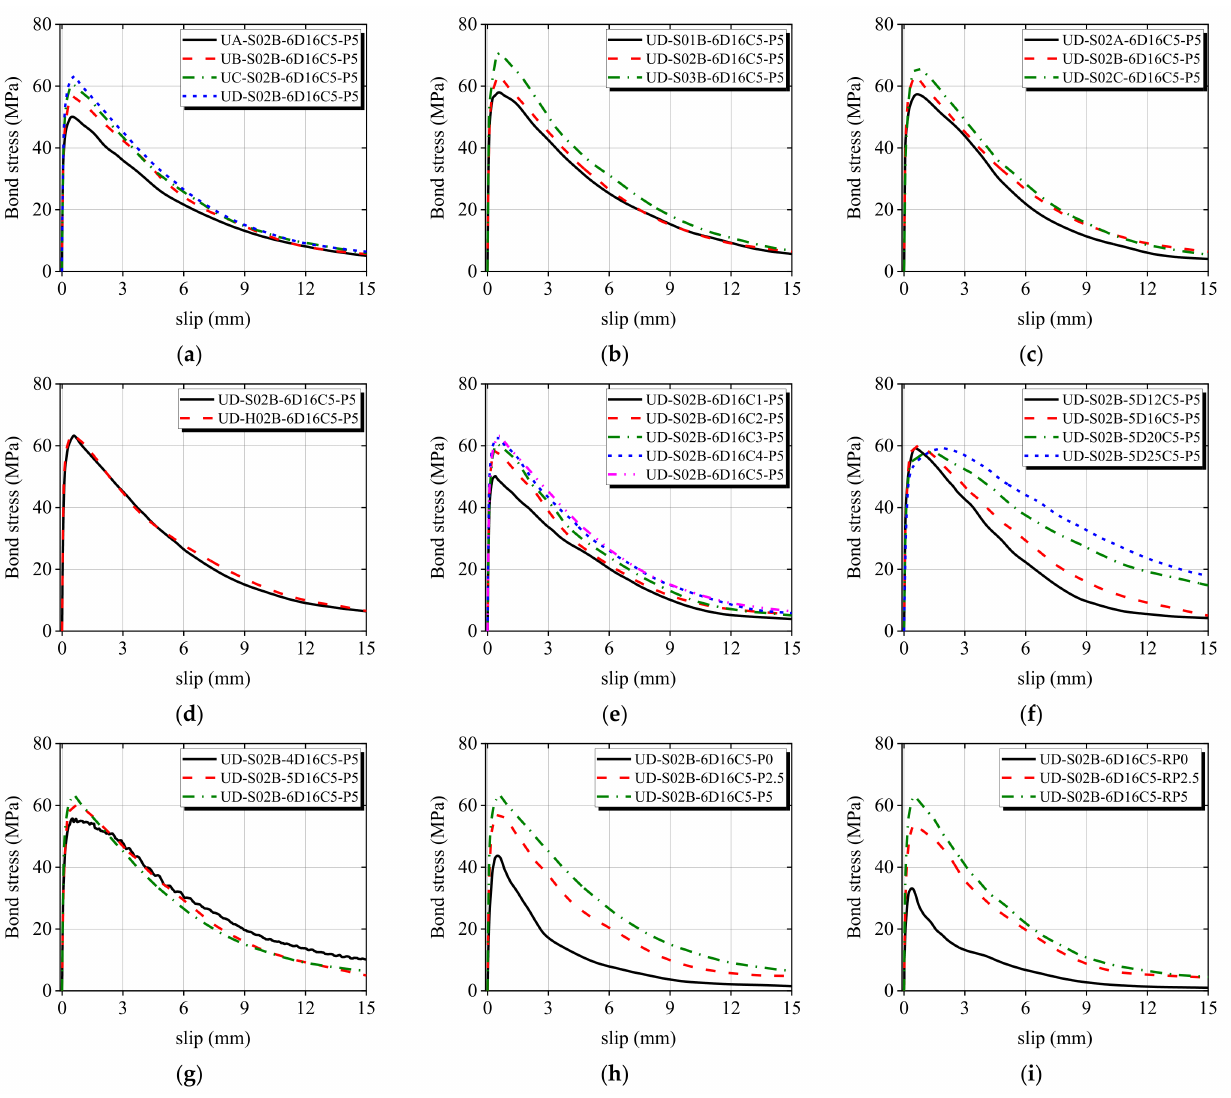
Figure 7. Bond-slip curves of specimens: ( a ) compressive strength; ( b ) fiber volume content; ( c ) fiber aspect ratio; ( d ) fiber type; ( e ) cover thickness; ( f ) rebar diameter; ( g ) rebar yield strength; ( h ) traditional pull-out test; ( i ) revised pull-out